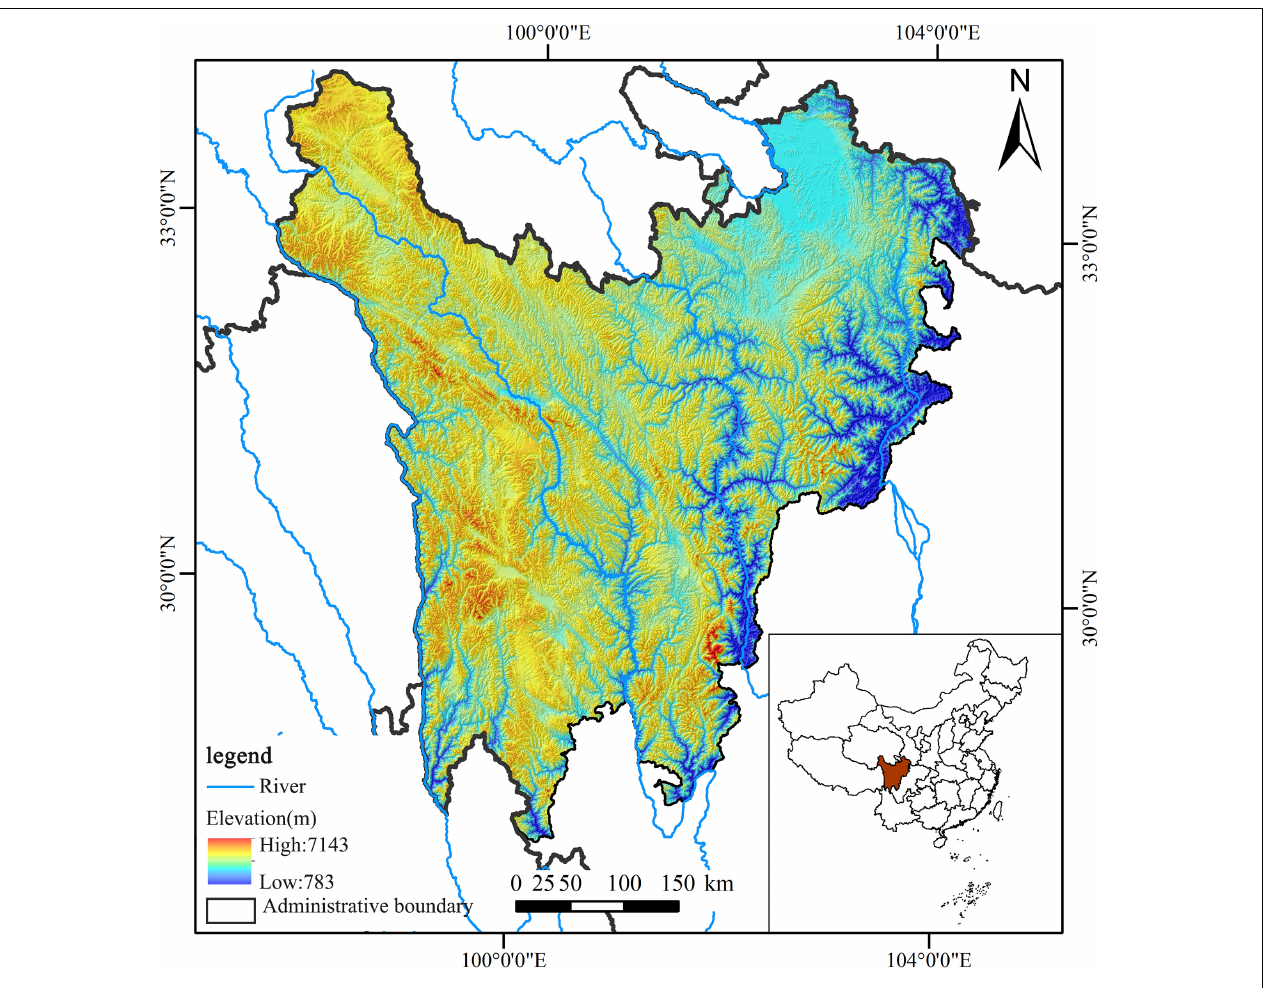
FIGURE 1 | Location and elevation of the study